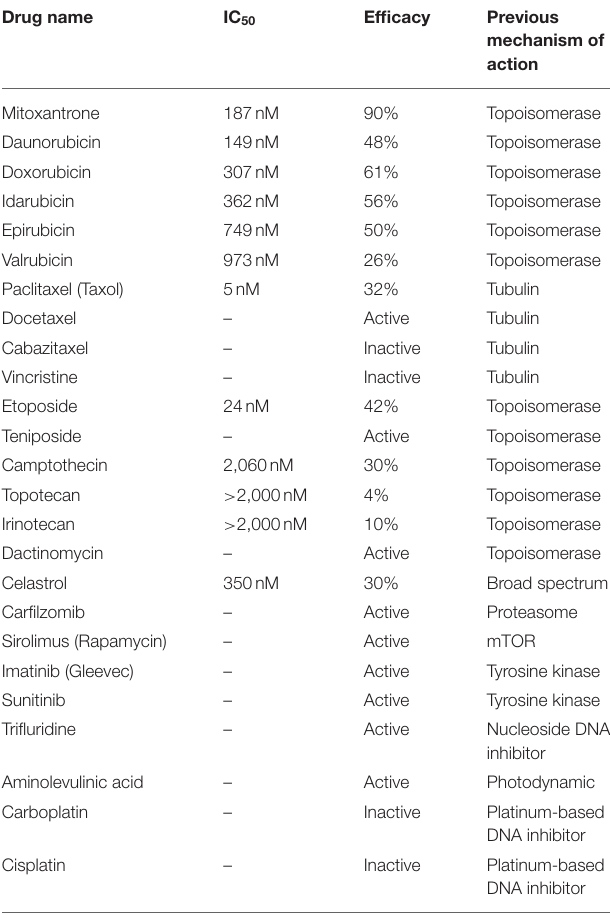
TABLE 1 | Summary of clinical oncology drugs tested for GT198